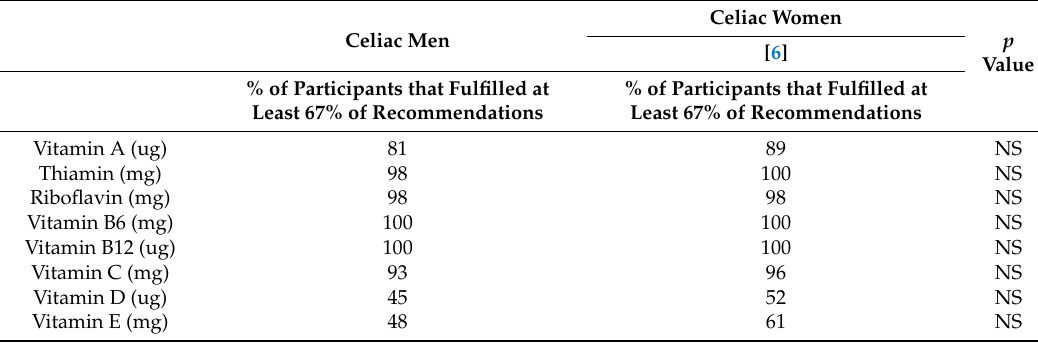
Table 5. Percentage of celiac men ( n = 42) and women ( n = 54) that fulfilled at least 2/3 of DRI (FESNAD, 2010) and their